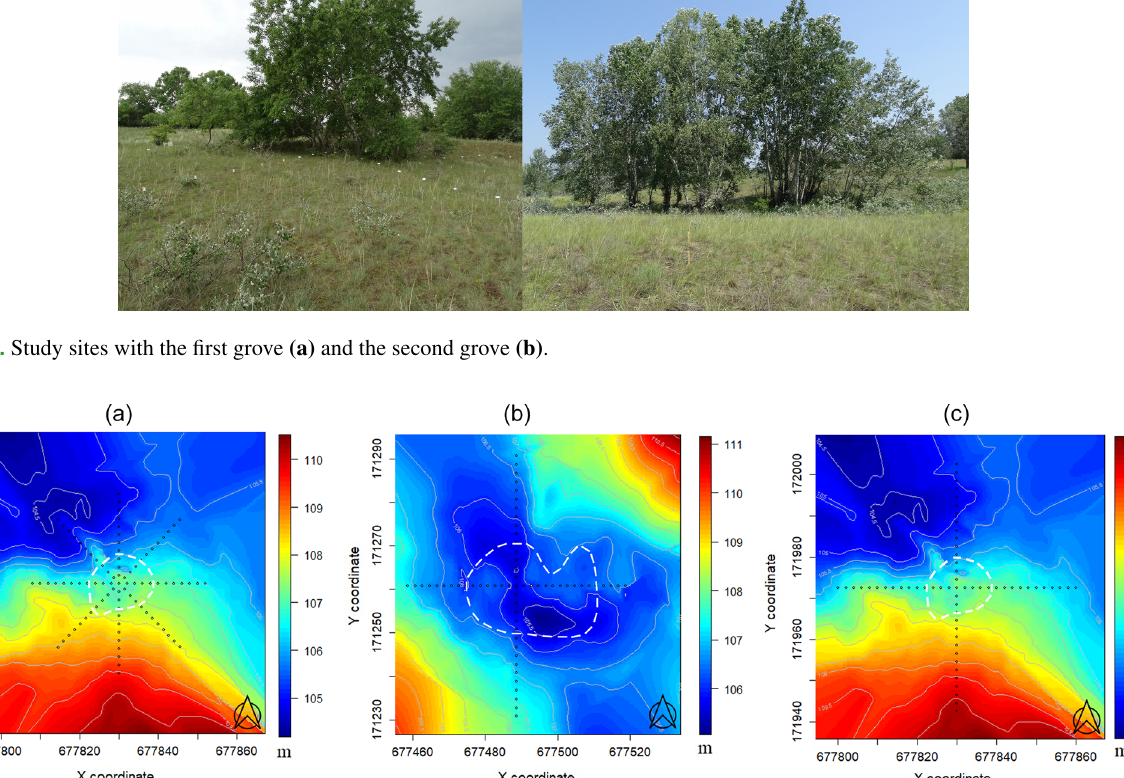
Figure 2. Digital elevation models and sampling arrangements of the sites ( a : first grove in 2018; b : second grove in 2019; c : first grove in 2020; white dashed line: visual tree edges; black dots: sampling positions). Coordinates refer to the Hungarian Unified National Projection system and are given in